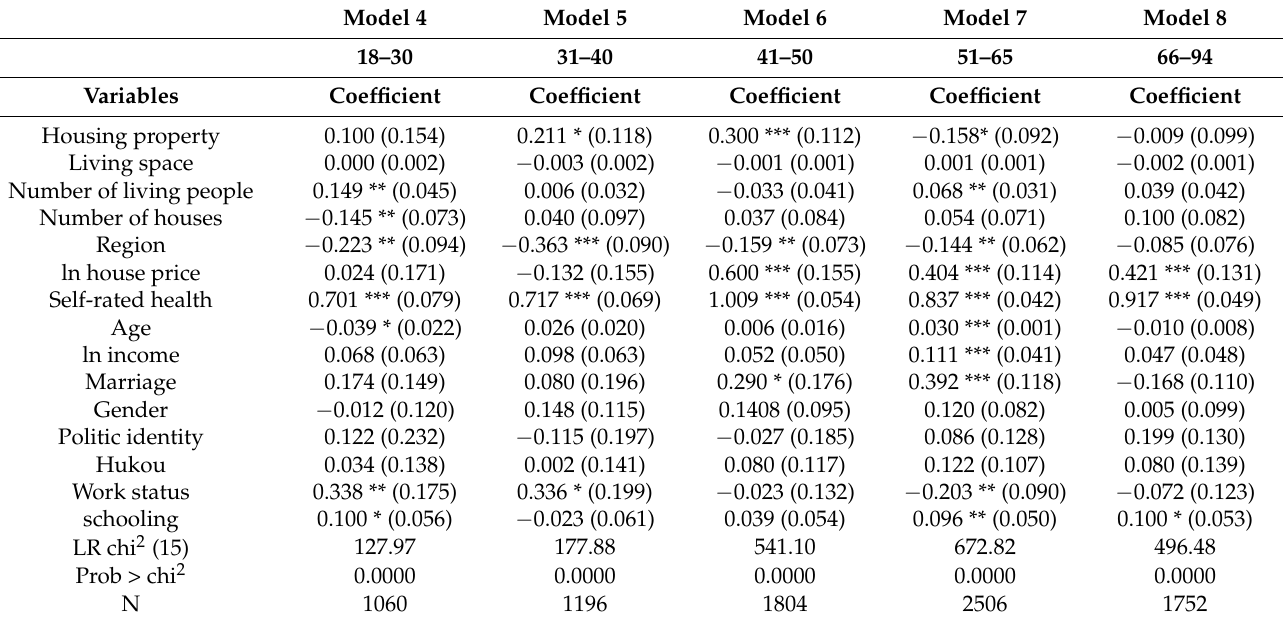
Table 6. Results for the impact of housing on mental health by age